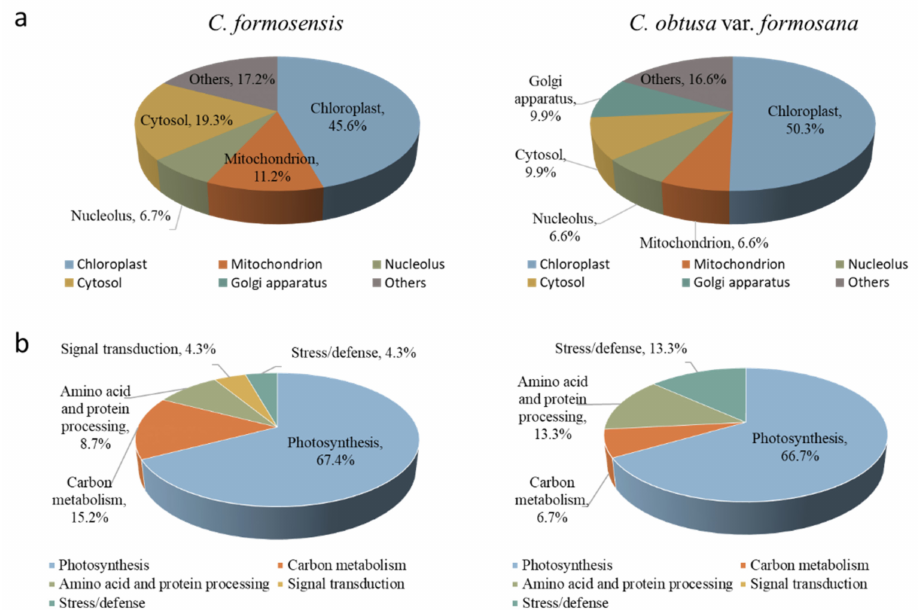
Figure 4. Subcellular localizations ( a ) and functional distribution ( b ) of identified proteins of C. formosensis and C. obtusa var. formosana